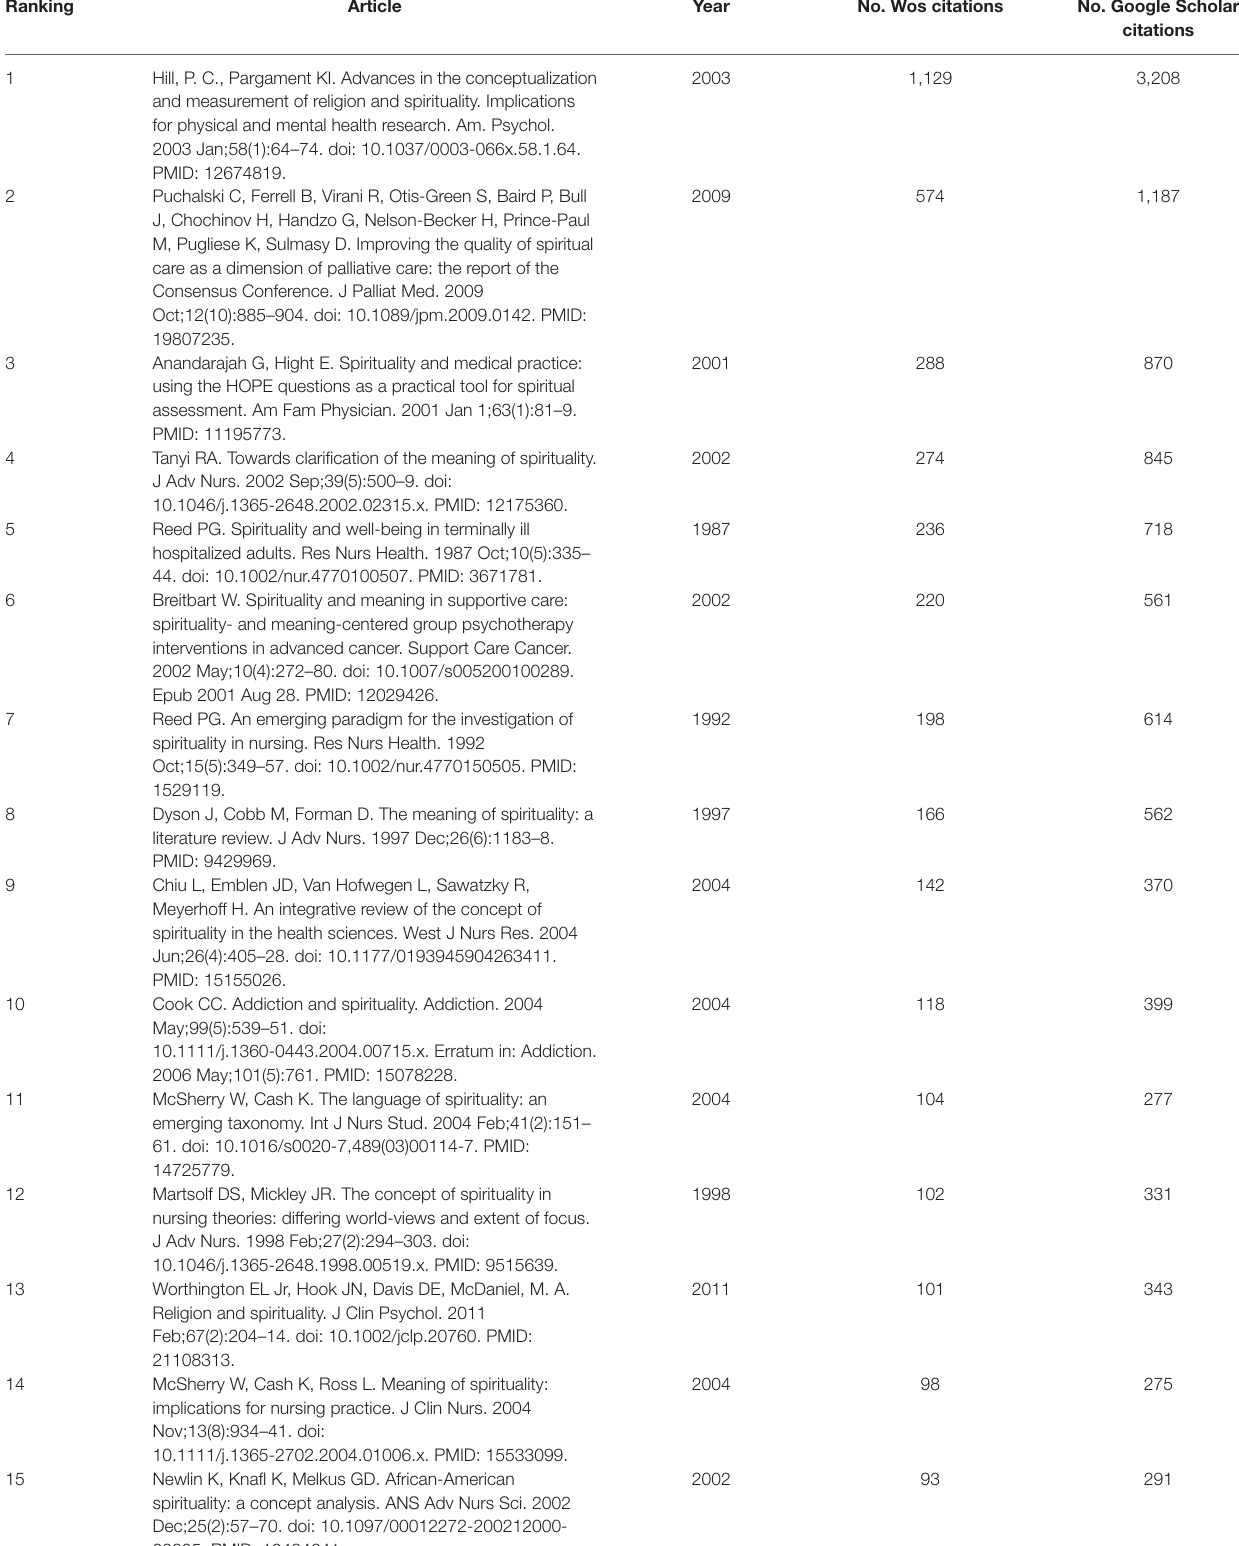
TABLE 1 | Most cited articles, according to Web of Science and Google Scholar Citations in November 3, 2020, found in the present study. Ranking Article